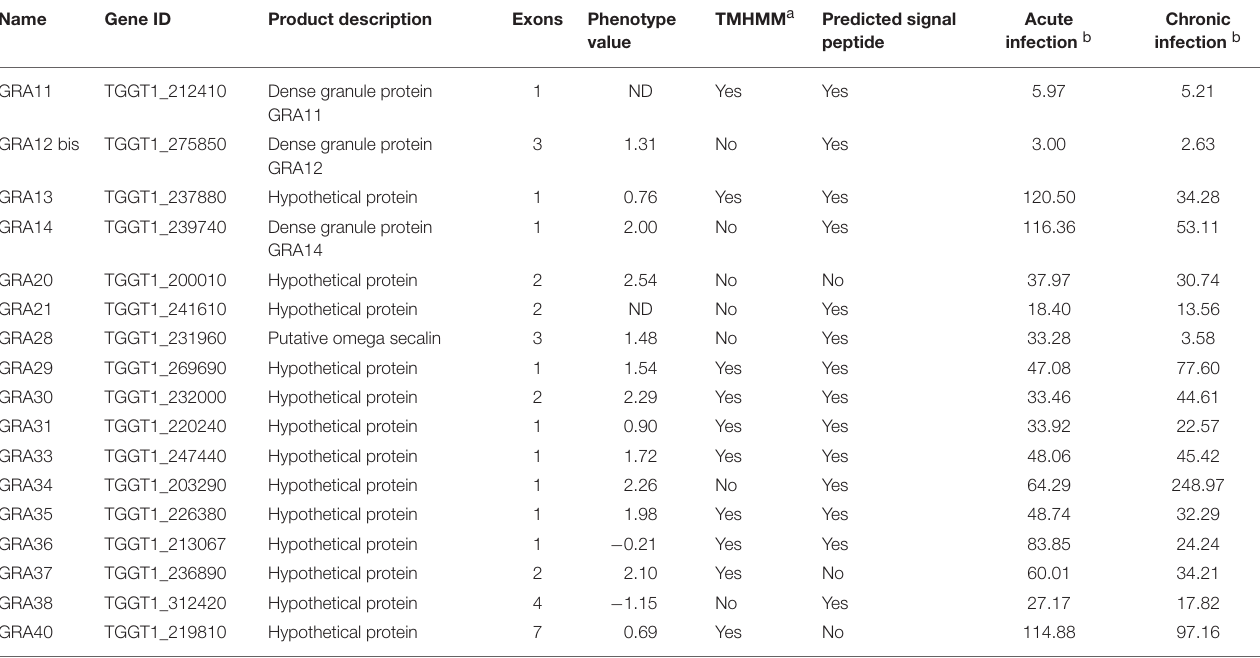
TABLE 1 | Bioinformatics features of GRA proteins of Toxoplasma gondii